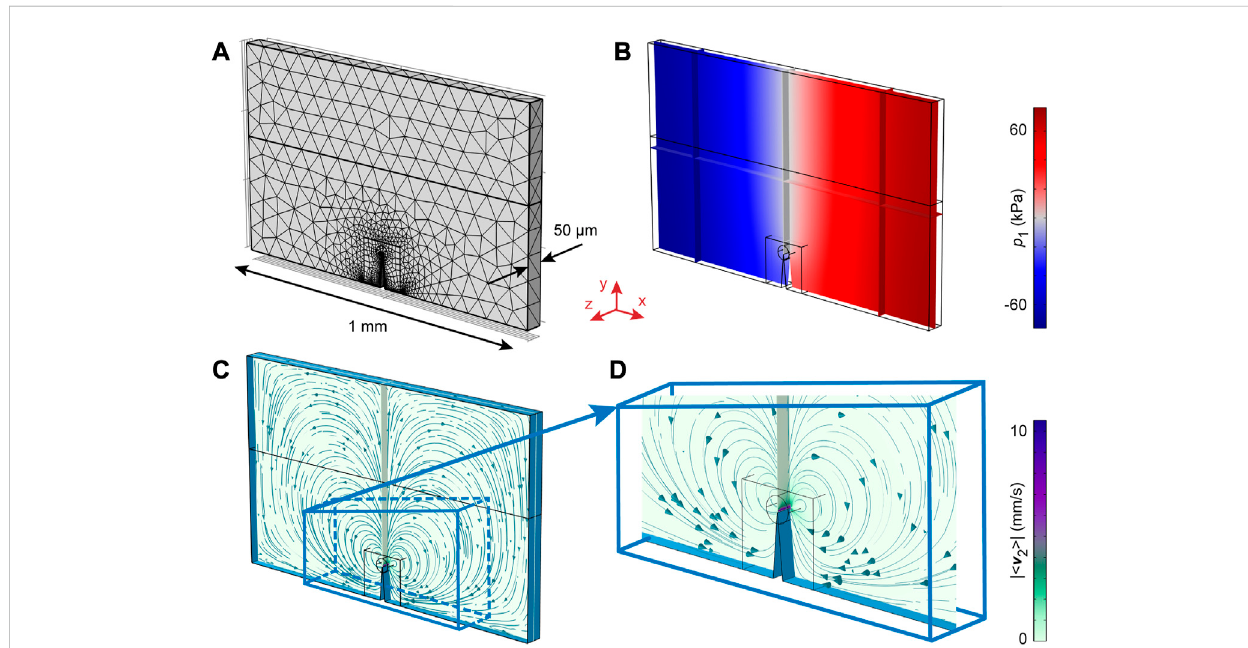
FIGURE 9 TheHybridmodelofarectangularchannelcontainingasharp-edgestructurein3D.Ananalysisisperformednearthe fi rstresonancemodeinwater along the channel width a = 1 mm, with h = 100 μ m, b = 150 μ m, d = 50 μ m, and α = 10 ° . (A) The mesh, (B) the fi rst-order pressure p 1 , (C) the Eulerian streaming velocity pattern, and (D) the zoomed-in streaming fi eld corresponding to (C) . The analysis of the pressure and streaming velocity fi elds in (B) – (D) isperformedatthemiddle xy -plane(at z = d /2),withsomeadditional xz -and yz -planesfororientation.Allthedisplayed fi eldscorrespondto f = 720 kHz. The excitation is imposed in the same direction (in phase) at x =± a /2 with v